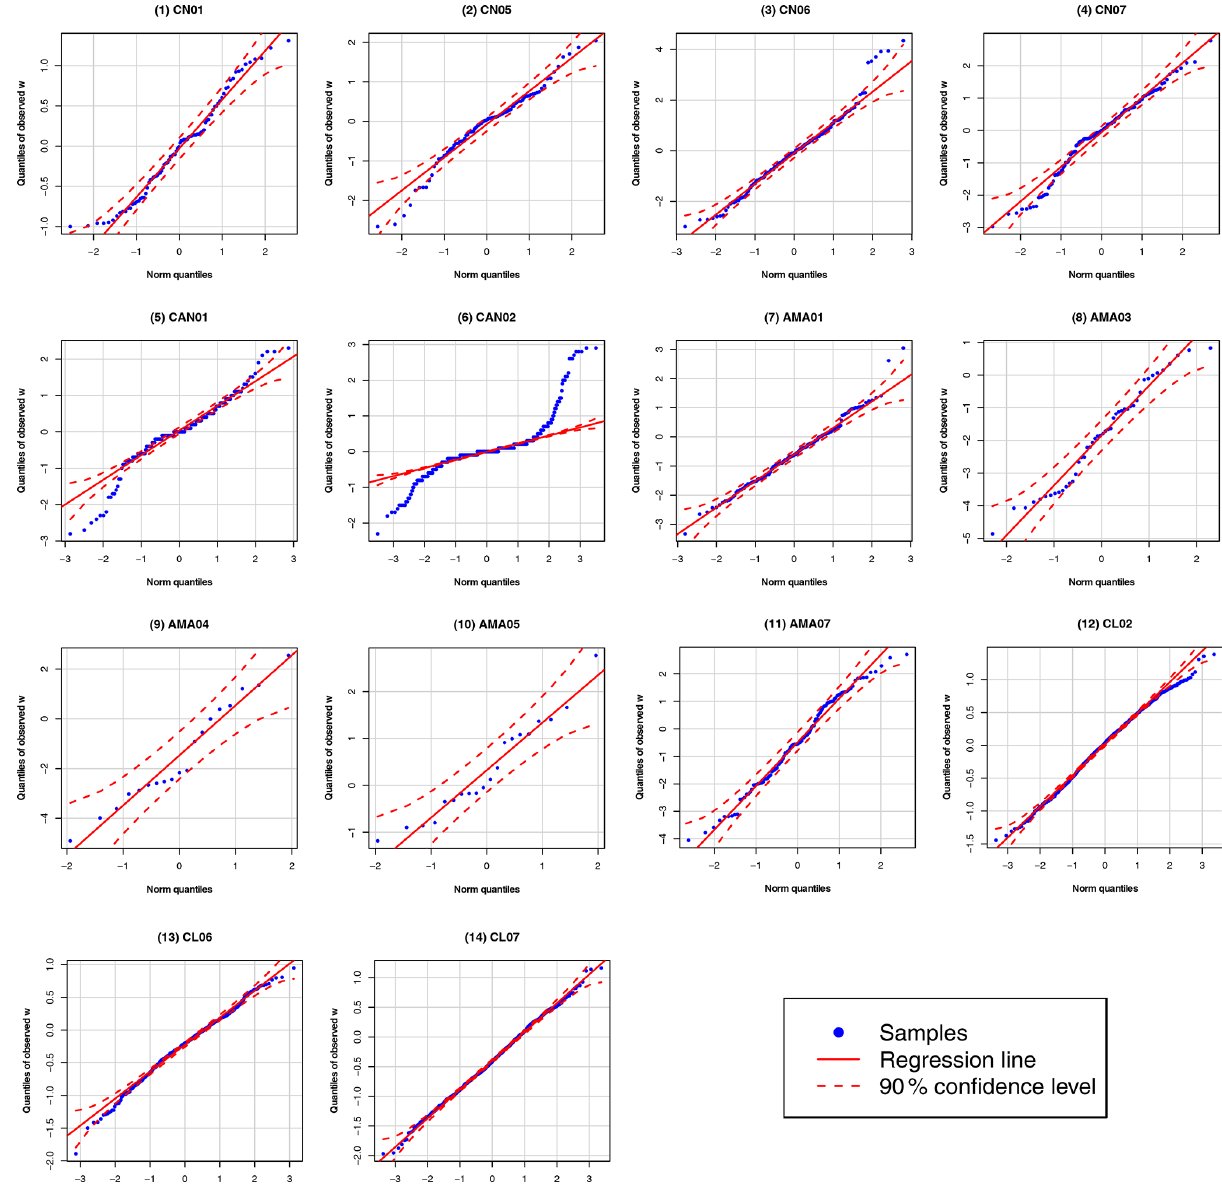
Figure B2. The normal quantile–quantile plot for comparing the observed w sampled by aircraft with a standard normal distribution for each cloud case with sufficient data. The linearity of the data points (blue dots) suggests that the observed w values are normally distributed under a 90% confidence